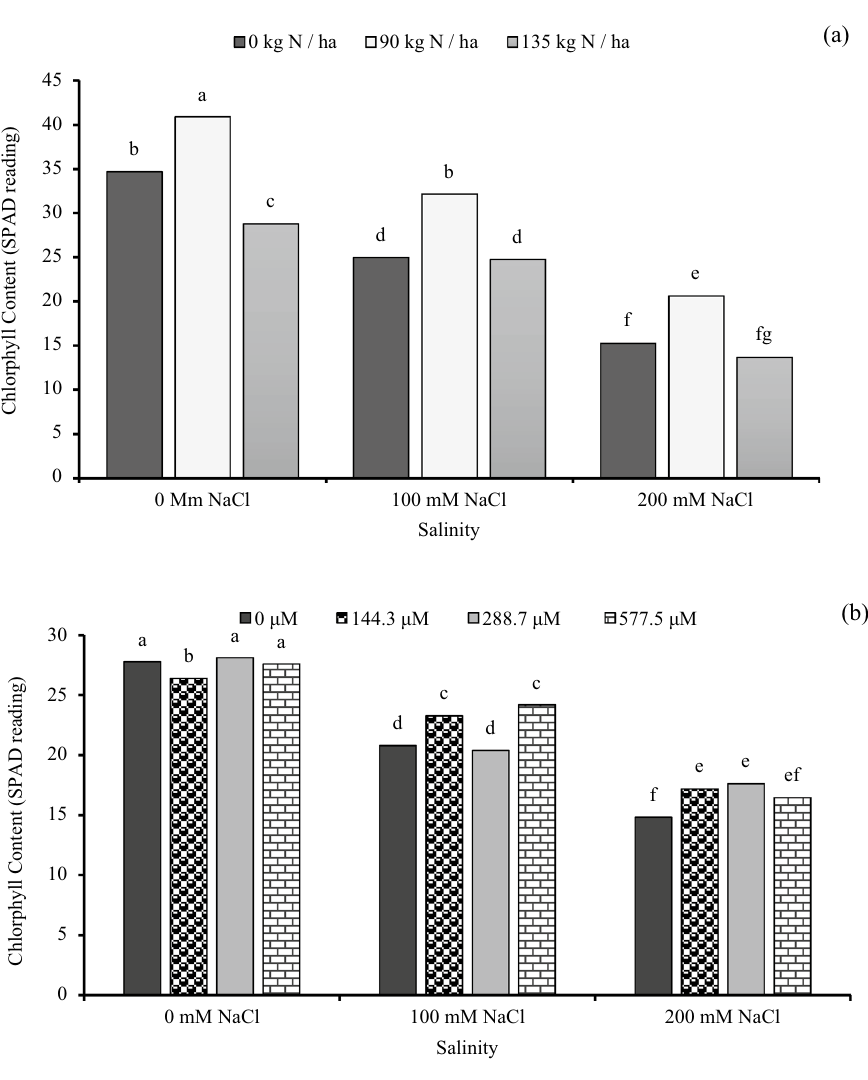
Figure 2. The effect of interaction between: ( a ) different concentrations of salinity × different concentrations of nitrogen and ( b ) different concentrations of salinity × different concentrations of gibberellic acid (GA 3 ) on chlorophyll content (SPAD reading). Bars with different letters are significantly different at the 0.05 probability. Means were separated by the LSD